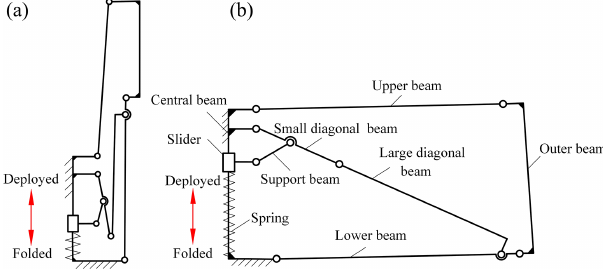
Figure 5. Sub-deployable unit. (a) Folded. (b) Deployed.